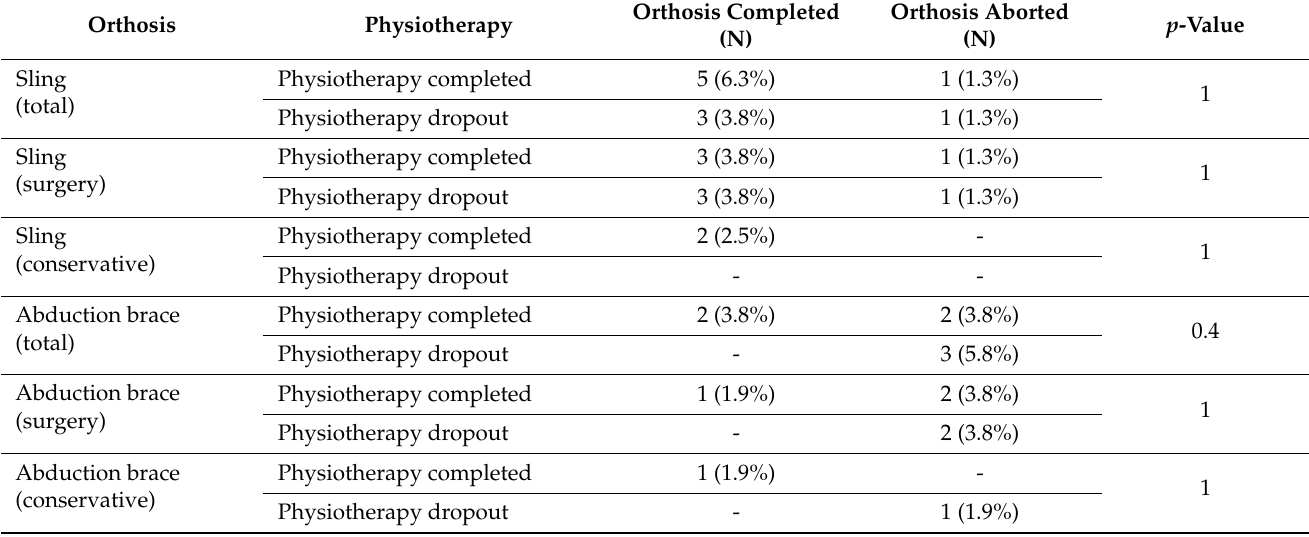
Table 4. Overview of secondary dislocations according to compliance